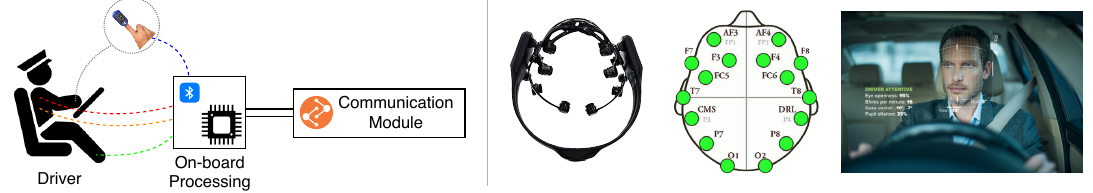
Figure 6. Example of a prototypical sensing monitor